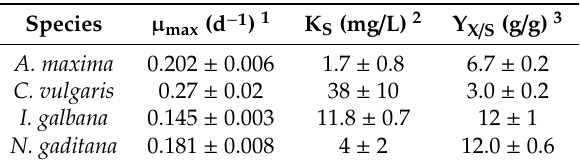
Figure 4. Biomass concentration (dry basis) ( ▲ ) and nitrate concentration in the culture medium ( ■ ) of A. maxima in MC1 ( A ), C. vulgaris in MC4 ( B ), I. galbana in MC3 ( C ) and N. gaditana in MC4 ( D ). Conditions for all cultivations: inoculum:culture medium ratio of 5:45 and a photoperiod of 12:12 h. Table 2. Monod’s kinetic parameters.